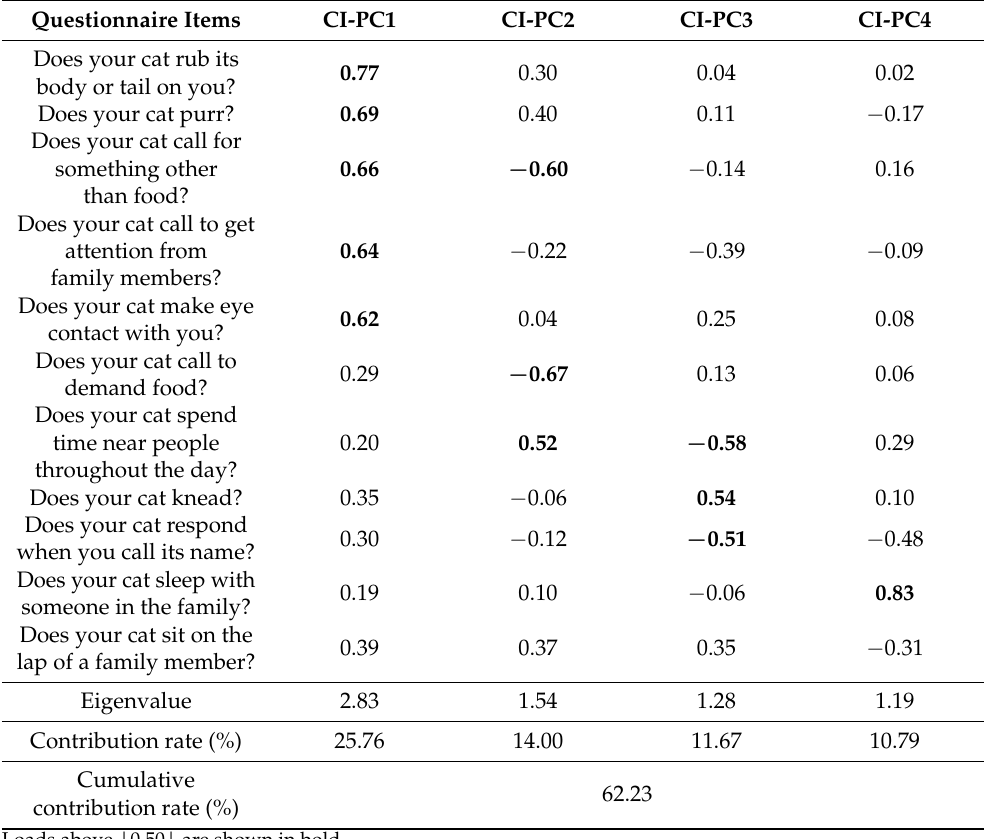
Table 5. Principal component loadings and contributions to cat-initiated interaction.